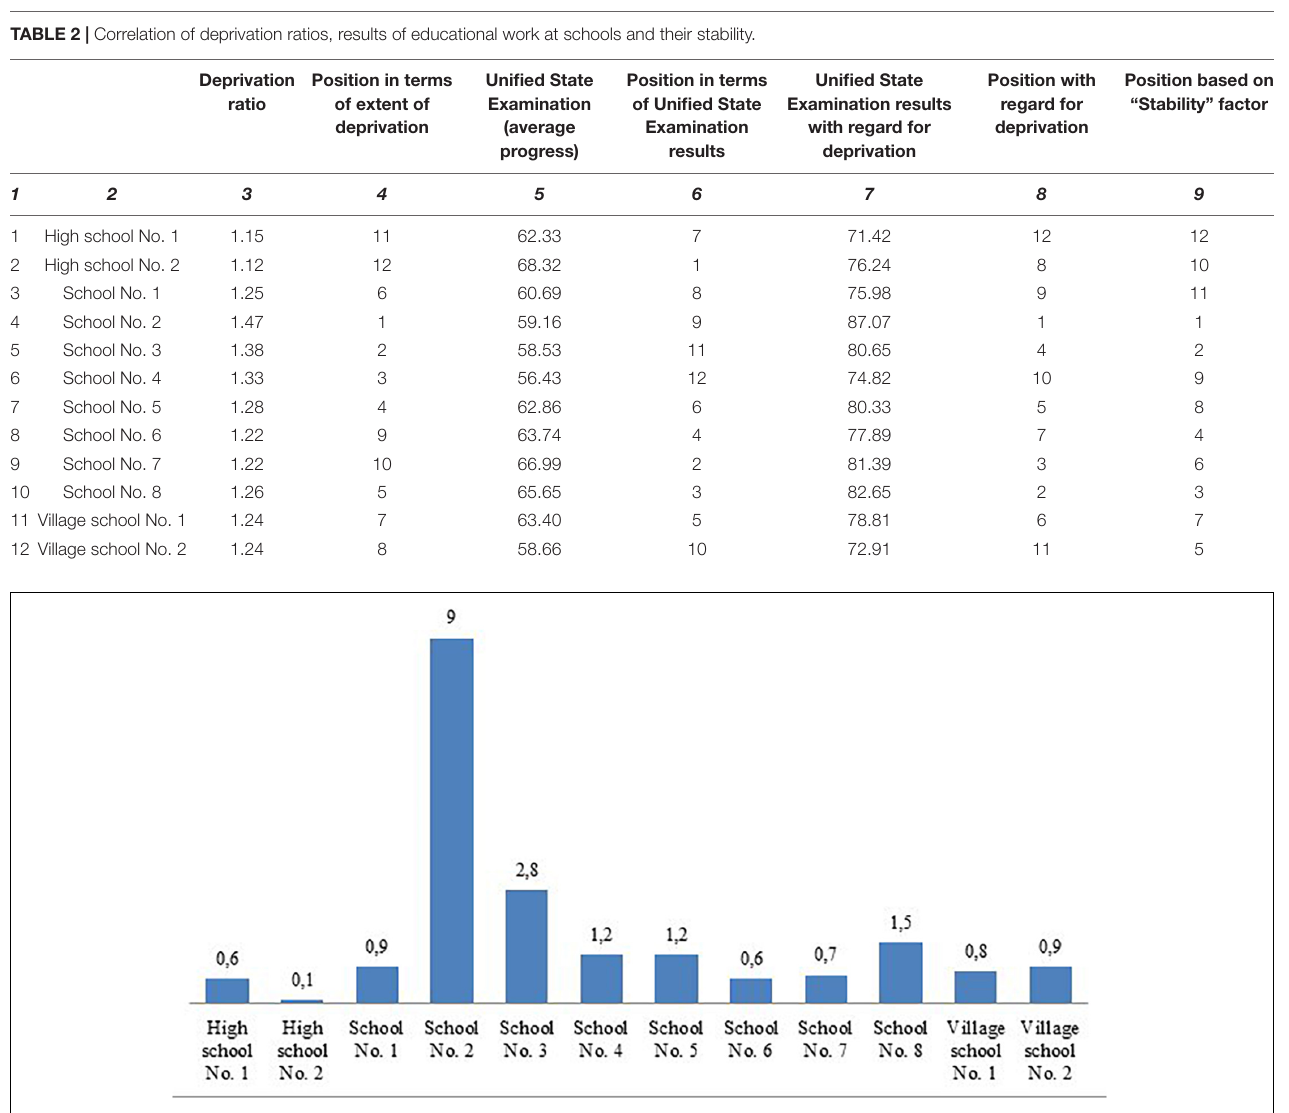
FIGURE 1 | Schools’ resiliency